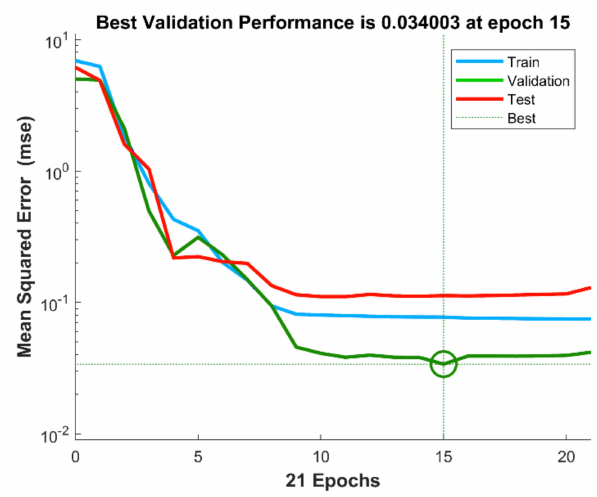
Figure 11. Training history of mean squared error